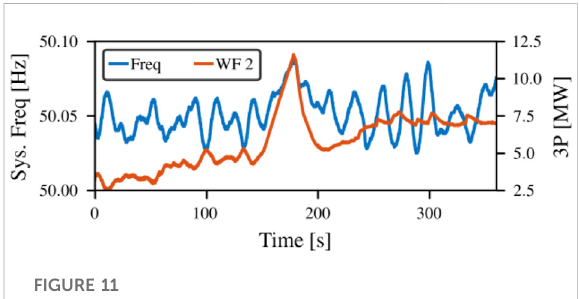
FIGURE 11 VLF Oscillation corresponding to 7.5 MW perturbation at a wind farm on Ireland ’ s power system.